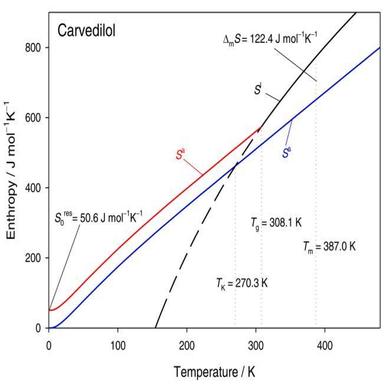
Entropy (S) of crystalline and amorphous carvedilol as a function of temperature. Symbols are explained in the main text.